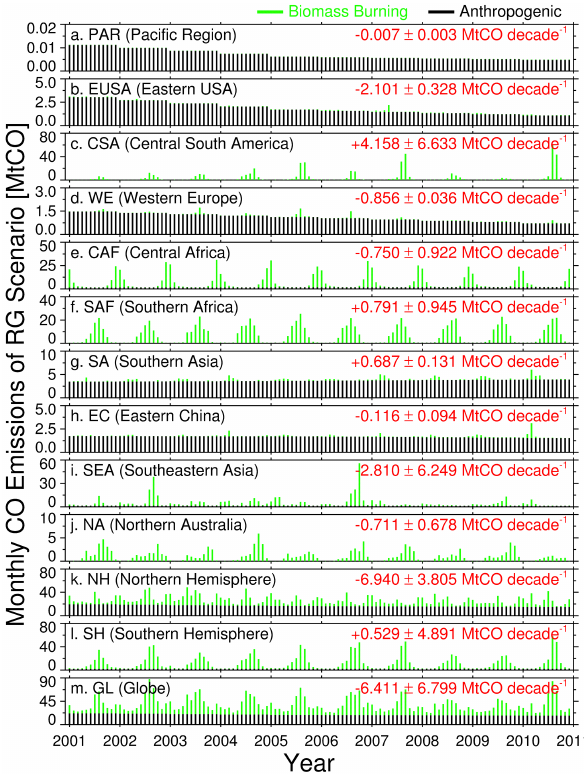
Figure 10. As in Fig. 9 but for ones of monthly RG CO emissions.